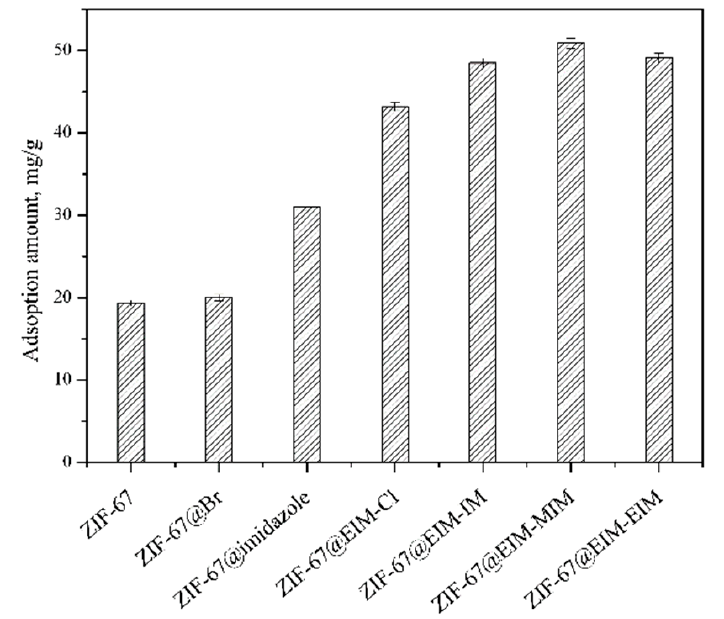
Figure 5. Maximum adsorption amounts of ZIF-67, ZIF-67@Br, ZIF-67@imidazole, ZIF-67@EIM-Cl, and three dual ILs-immobilized ZIF-67s.